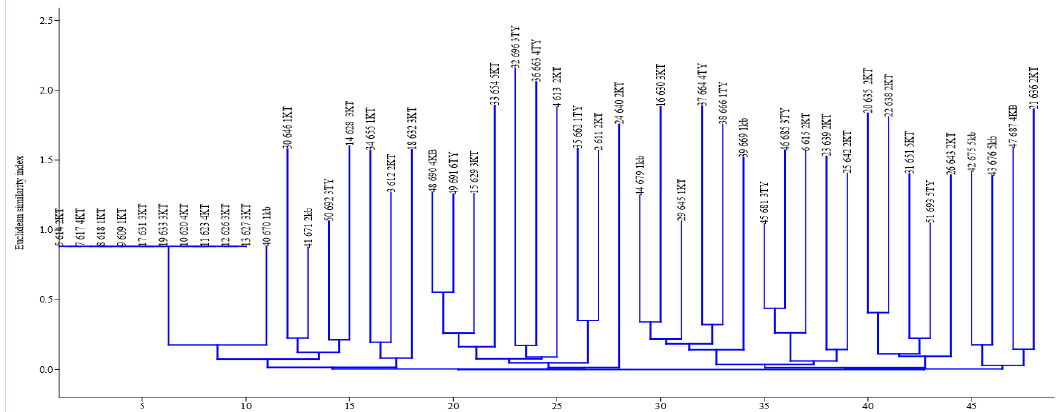
Figure 3. A representative ERIC-PCR fingerprint gel image. A = 1kb molecular ladder, lines 1 to 38 = P. shigelloides isolates.